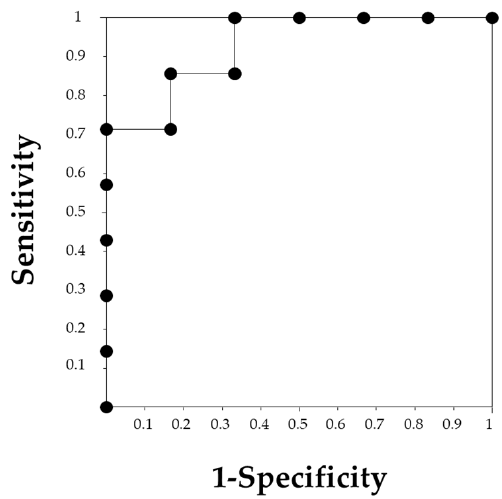
Figure 5. The receiver operating characteristic (ROC) curve for neutrophil-to-lymphocyte ratio (NLR) for recovery from renal failure. The NLR of 5.0 was determined to be a cutoff value with a sensitivity of 83.3% and a specificity of 85.7%, and the area under the curve was 0.929. We further investigated histological changes in the temporary HD group and maintenance HD group (Table 3, Figures 6,7). The number of globally sclerotic glomeruli was significantly lower in the temporary HD group (9.0% ± 10.1% vs. 53.0% ± 9.7%, p < 0.001), whereas the number of glomeruli with cellular crescent was significantly higher in the temporary HD group (27.9 (0–73.3) vs. 0 (0–13.3), p = 0.022). Table 3. Histological changes in the temporary hemodialysis (HD) and maintenance HD groups. Temporary HD ( n = 6) Maintenance HD ( n = 7) p Value Cellular crescent (%) 30.4 ± 24.1